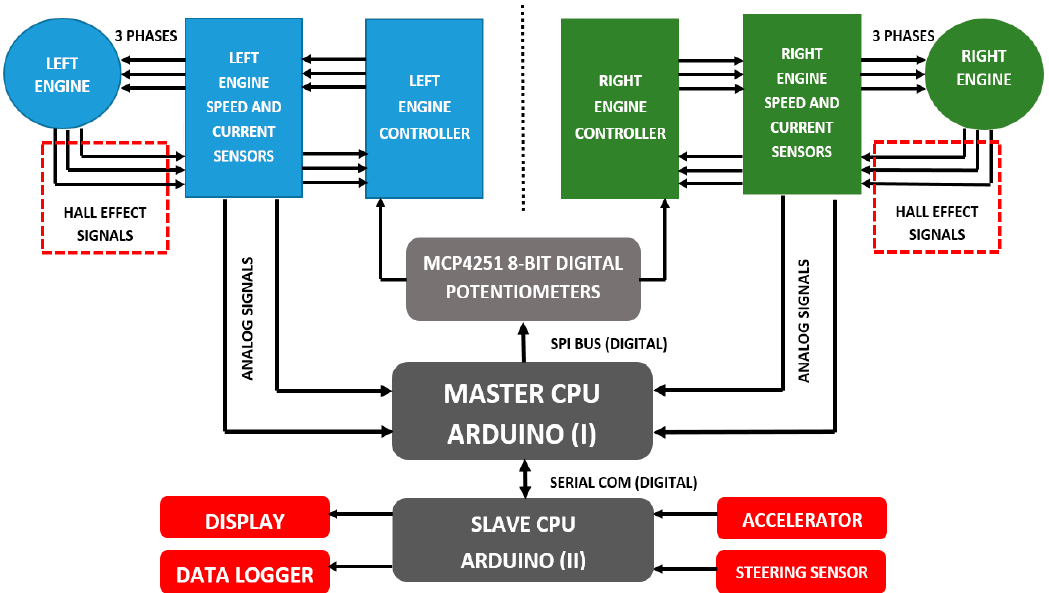
Figure 4. Schematic of the architecture of the ED. The power control signals are generated by a master CPU upon the information of the analog sensors managed by a secondary slave control unit.